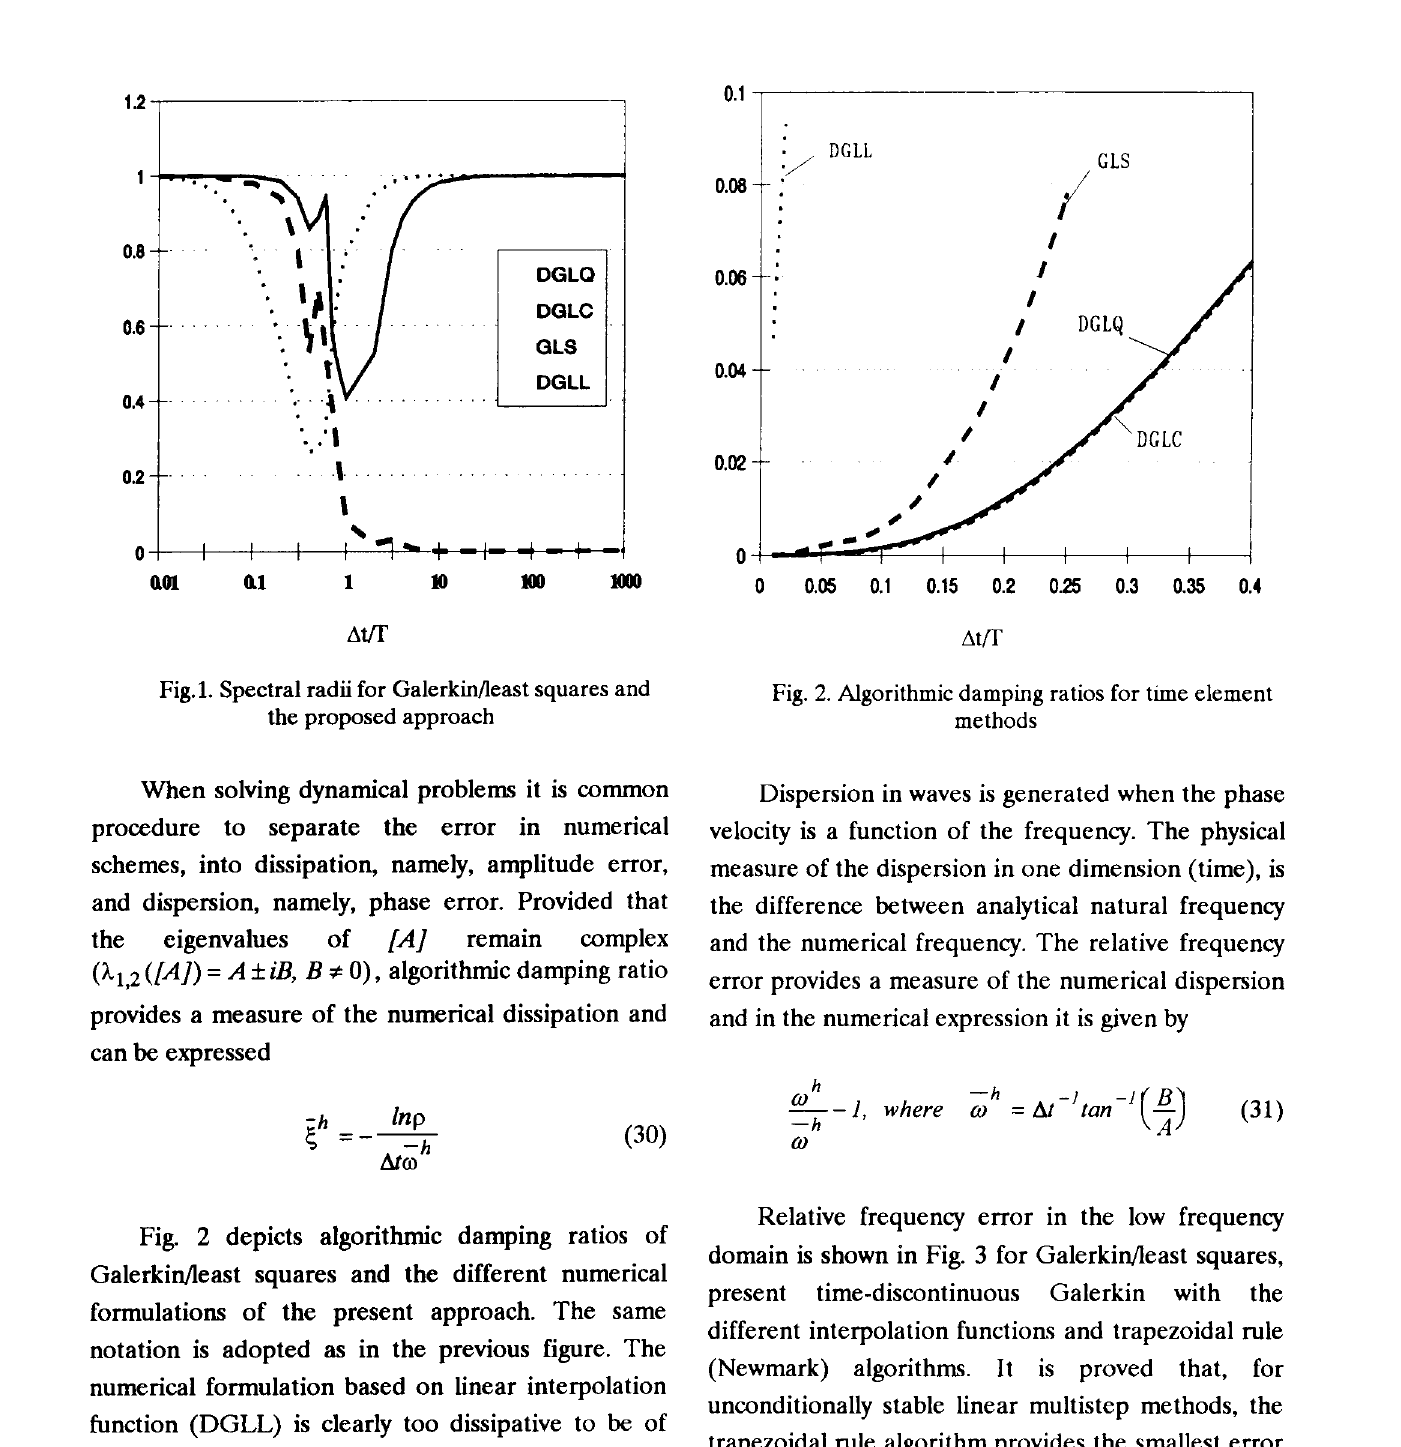
Fig. 2. Algorithmic damping ratios for time element